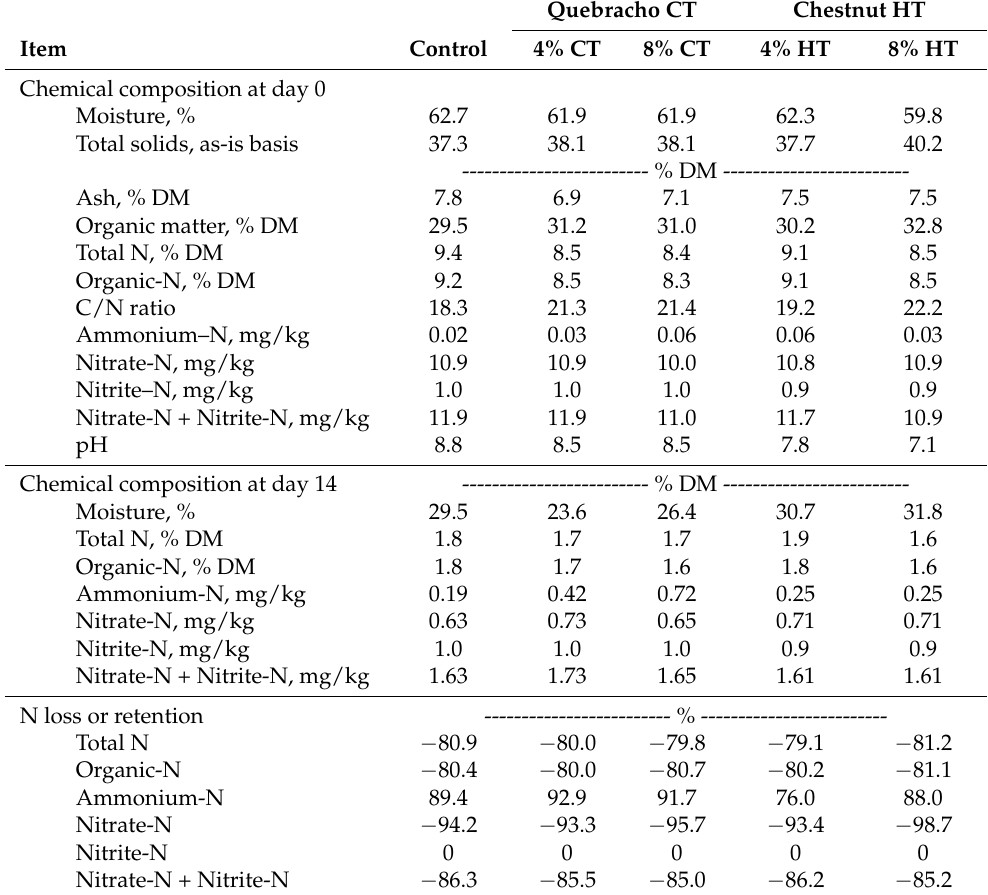
Table 1. Chemical composition of experimental dairy cattle manure at day 0 and day 14. Quebracho CT Chestnut HT Item